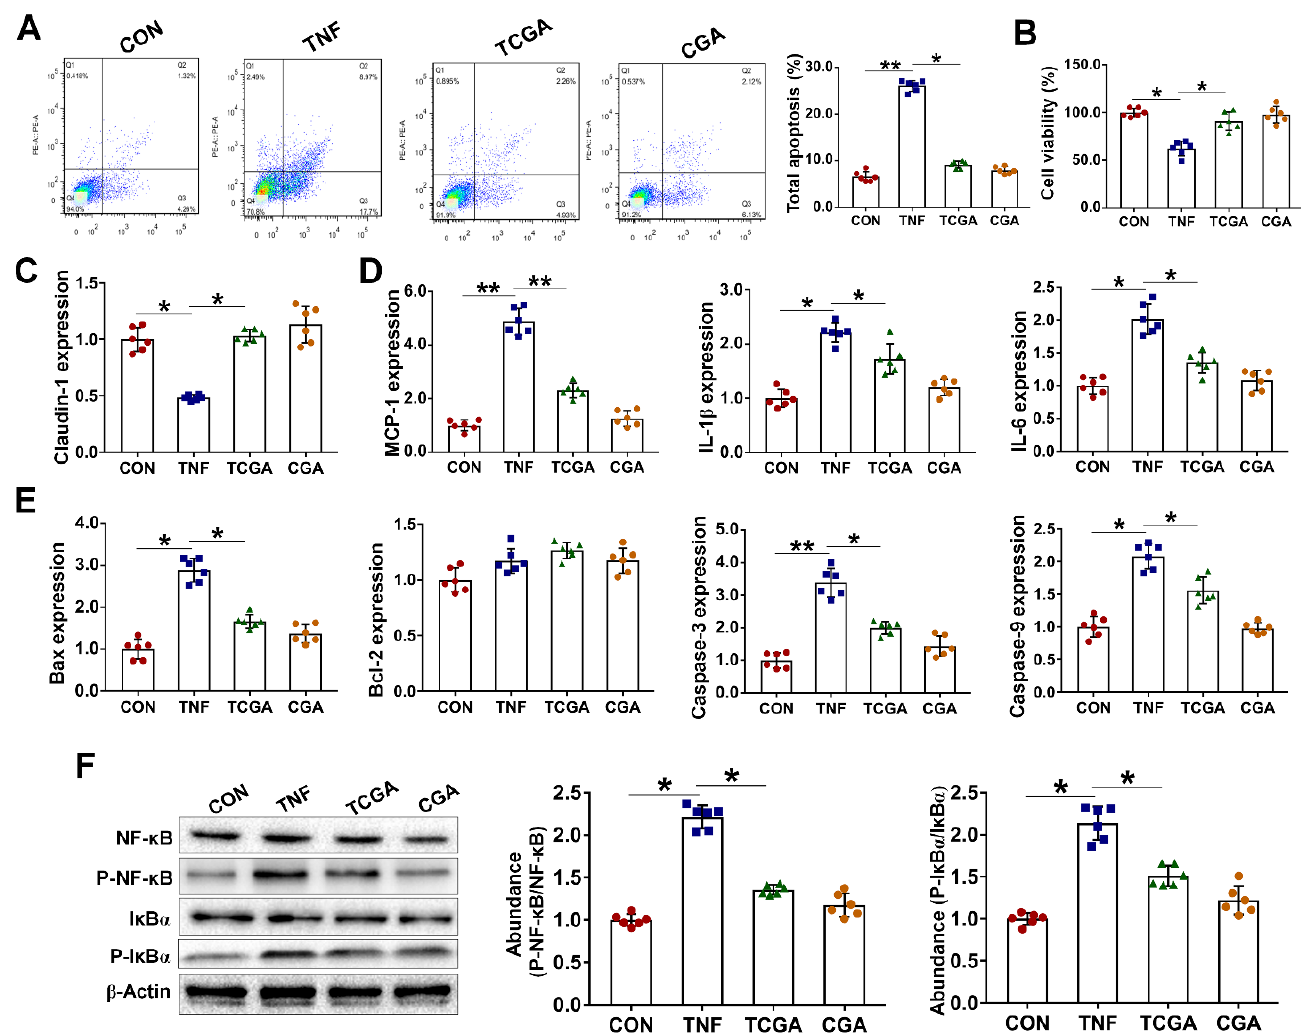
Figure 5. Chlorogenic acid (CGA) attenuates tumor necrosis factor- α (TNF- α ) induced inflammation and injury in IPEC-J2 cells. ( A ) Analysis of cell apoptosis by flow cytometric assays. In each diagram, Q1 represents the percentage of nonviable and necrotic cells, Q2 represents the percentage of late apoptotic cells, Q3 represents the percentages of early apoptotic cells, and Q4 represents the percentage of live cells. IPEC-J2 cells were plated in 24-well plates at a density of 1 × 10 5 cells/well and pretreated by CGA (50 µ M) for 6 h, and the cells were then challenged by TNF- α (50 ng/mL) for 3 h ( n = 6). ( B ) Assays of cell viability. ( C ) qPCR analysis of the expressions of claudin-1. ( D ) Expressions of critical inflammation-related molecules. ( E ) Expressions of critical apoptosis-related proteins. ( F ) Western-blot analysis of critical signaling proteins involved in the NF-kappa-B inhibitor alpha (I κ B α )/ nuclear factor- κ B (NF- κ B) pathway. CON, cells without being treated; TNF, cells were only treated by 50 ng/mL TNF- α ; TCGA, cells were pretreated by 50 µ M CGA for 6 h and were then treated by 50 ng/mL TNF- α for 3 h; CGA, cells were only treated by 50 µ M CGA. * p < 0.05, ** p <